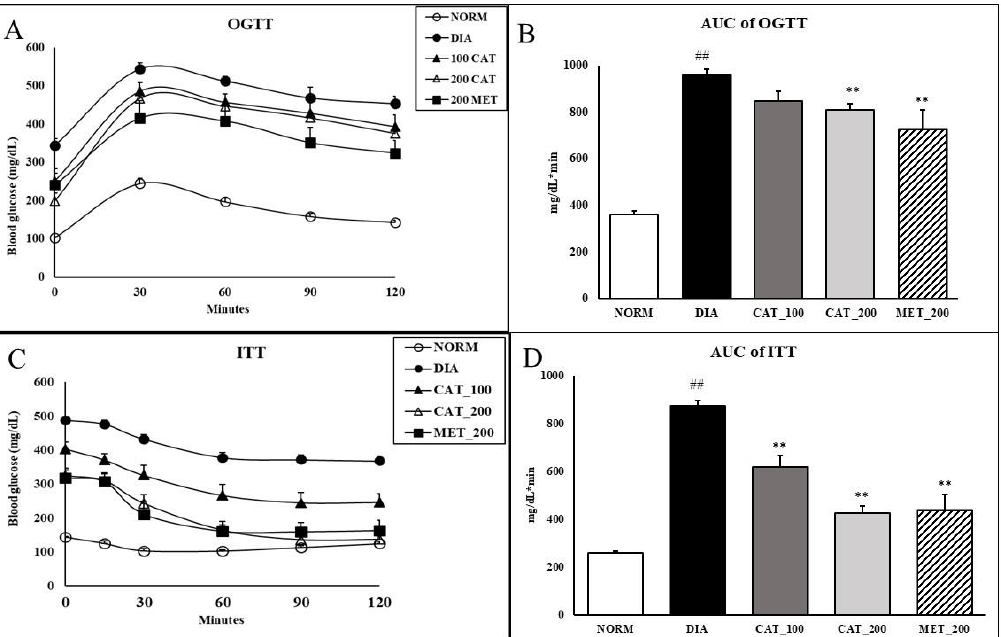
Figure 2. Effect of catalpol and metformin on OGTT and ITT on day 28 of treatment. ( A ) OGTT curve; ( B ) AUC of OGTT; ( C ) ITT curve; ( D ) AUC of ITT. NORM: Normal control; DIA: Diabetic control; CAT_100: Catalpol (100 mg/kg, p.o.); CAT_200: Catalpol (200 mg/kg; p.o.); MET_200: Metformin (200 mg/kg, p.o.). Data were expressed in mean ± SEM ( n = 8). ## p < 0.01 vs. NORM; ** p < 0.01 vs. DIA.